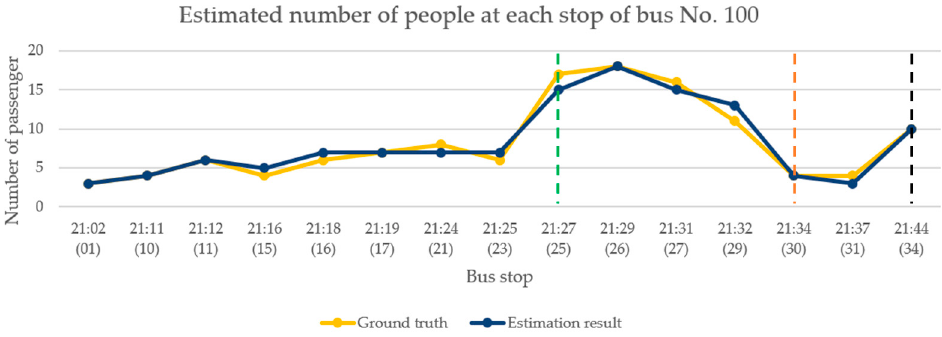
Figure 16. Continuous image analysis for nighttime. Table 5. Evaluation of continuous image model for nighttime.